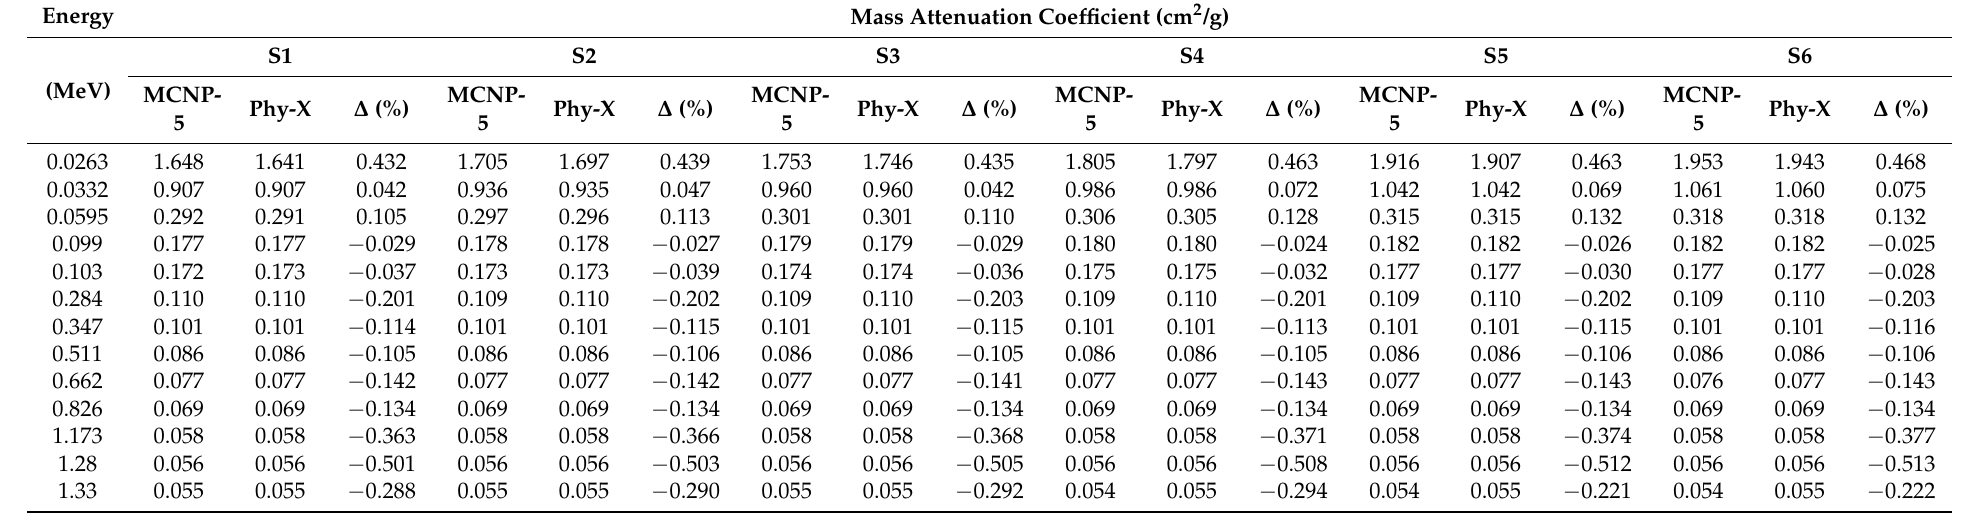
Table 3. The mass attenuation coefficient of the investigated glass samples using MCNP5 and Phy-X